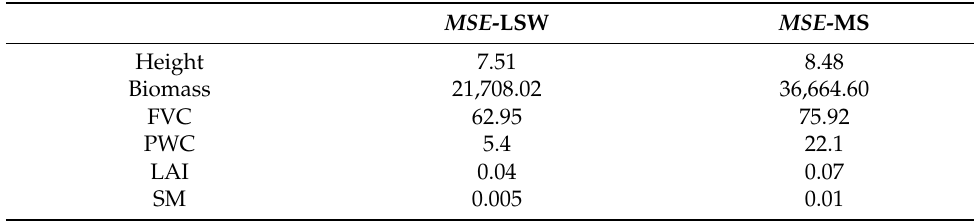
Table 7. MSE of LSW and MS methods.